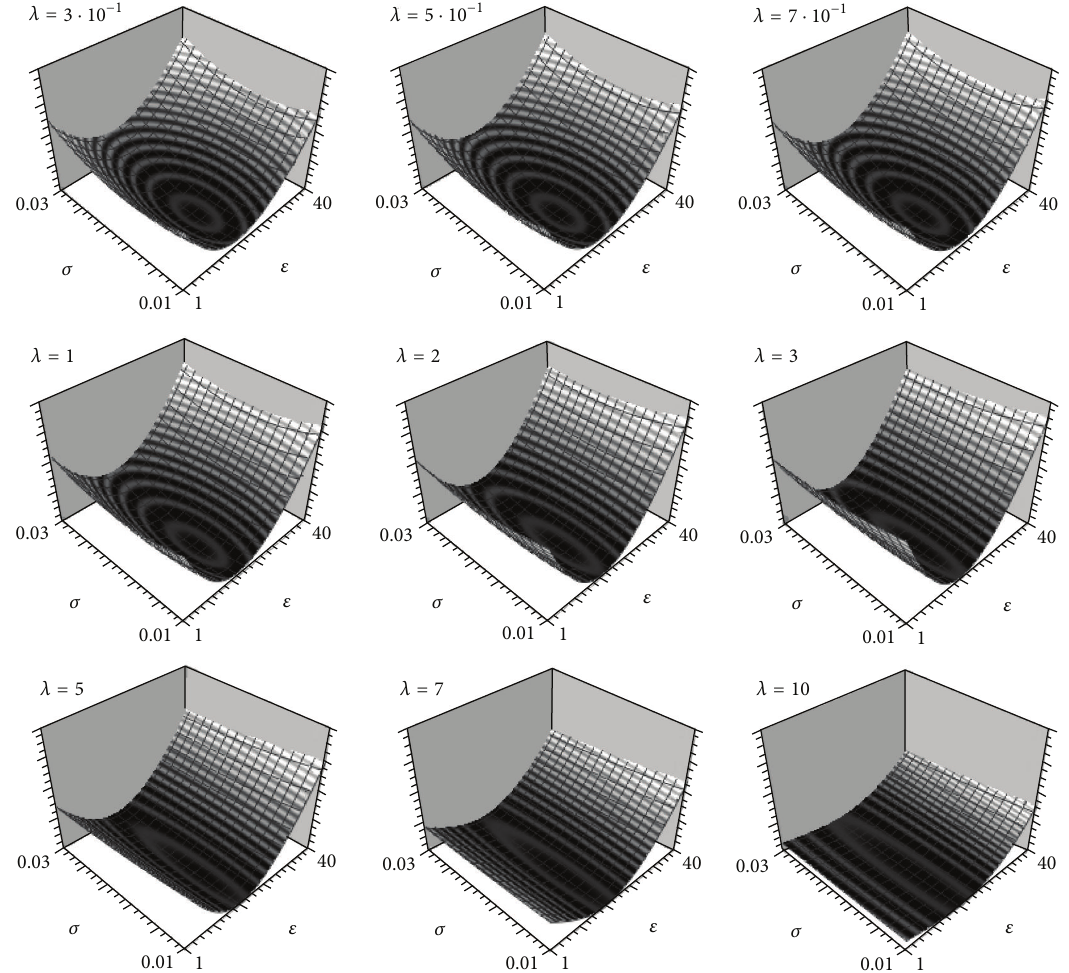
Figure 2: The behavior of the residual functional 𝐽[𝜘 0 ] for various values of 𝜆 . 450 values of 𝜔 were taken from the segment [𝜔 0 /10; 10𝜔 0 ] with constant step.